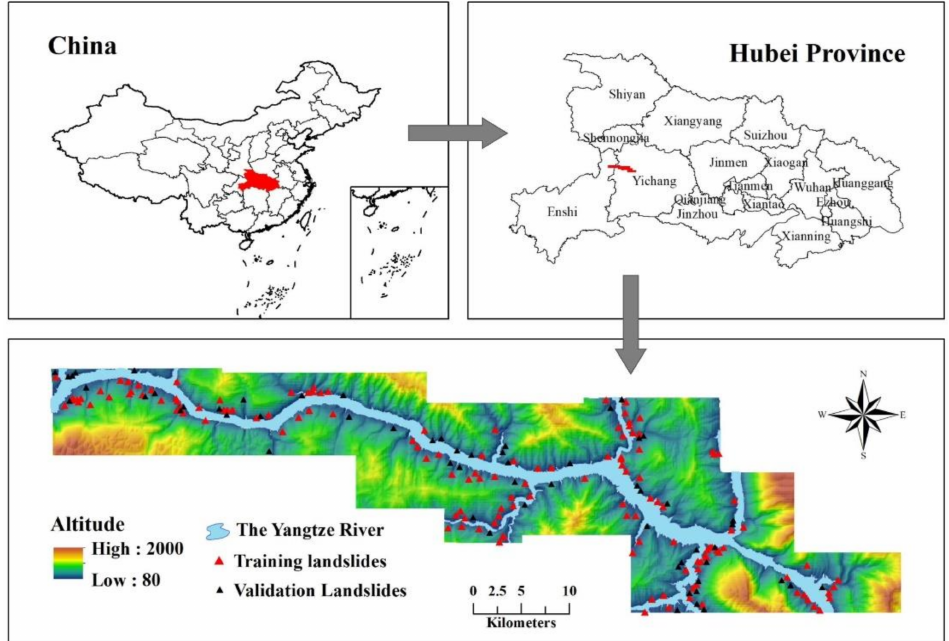
Figure 1. Location of the study area with landslide